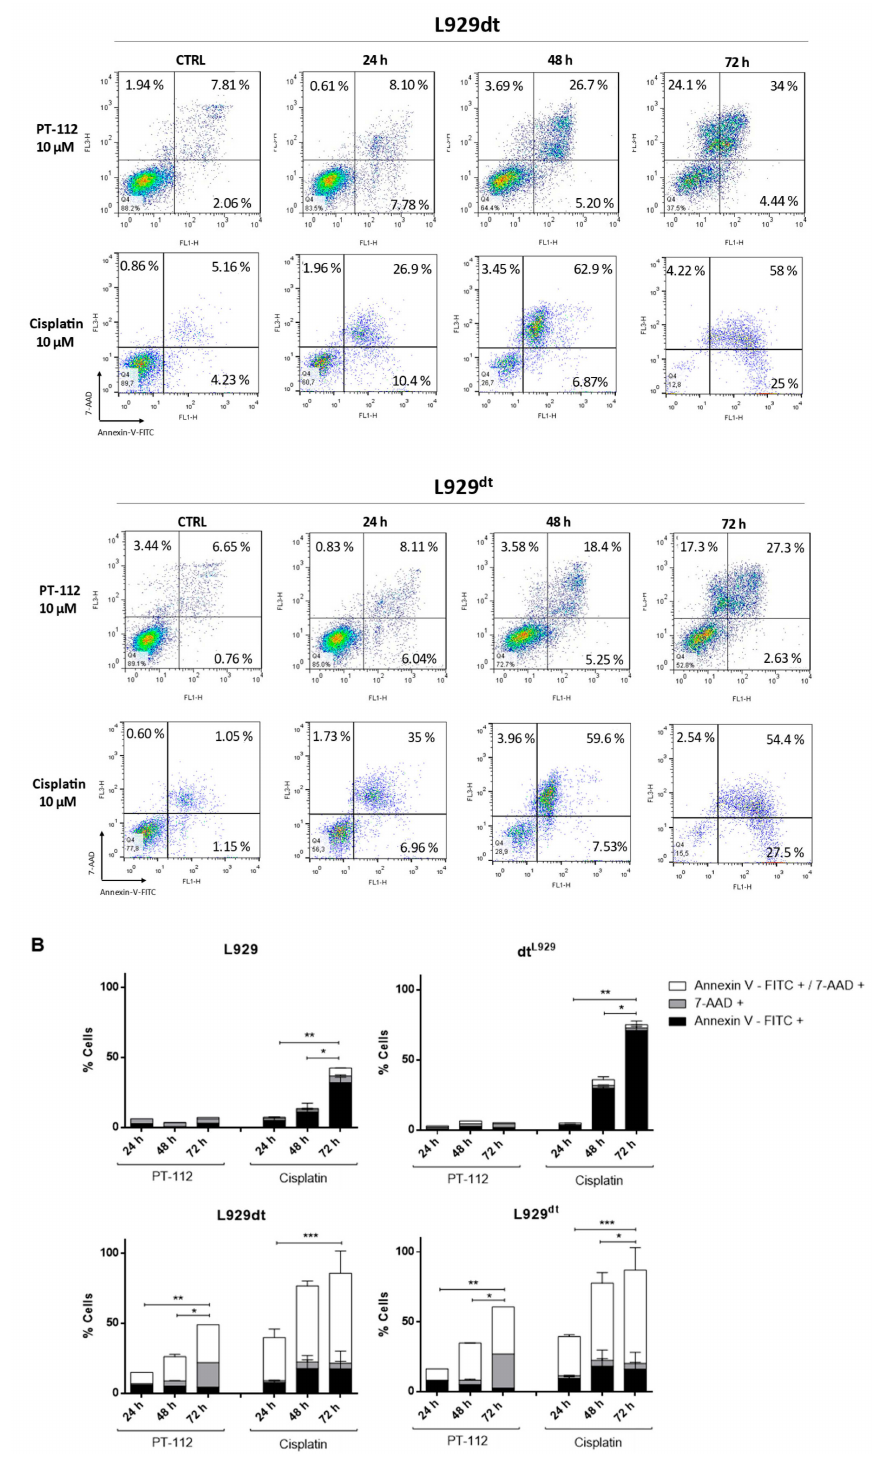
Figure 2. Cytotoxicity of PT-112 or cisplatin. Parental L929, L929dt and cybrids cells were incubated with 10 µ M of PT-112 or cisplatin for 24, 48 and 72 h. Then, cells were simultaneously stained with annexin-V-FITC and 7-AAD and analyzed by flow cytometry. ( A ) Dot plots represent the staining evolution of the treated cell population compared to the control. ( B ) Graph bars correspond to a graphical representation of obtained data reporting cell percentage in each quadrant of dot plots. Results are shown as mean ± SD of at least 2 independent experiments performed in duplicate. *, p < 0.05; **, p < 0.01; ***, p <